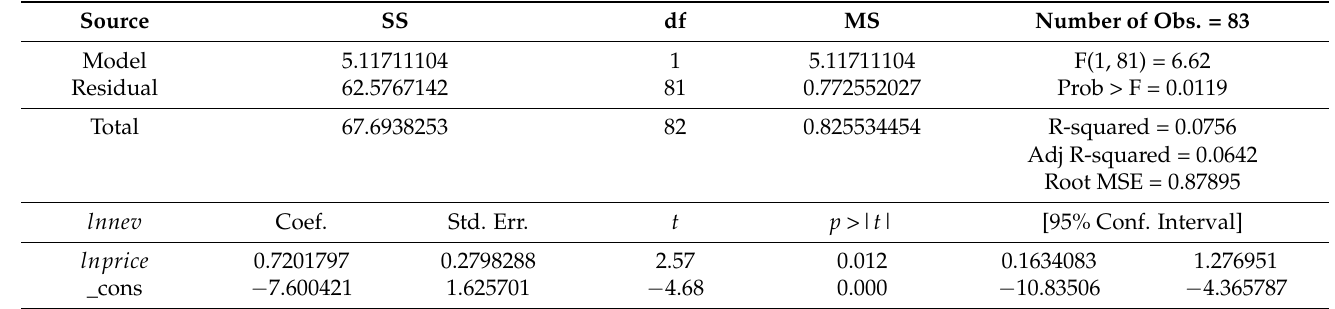
Table 6. New Energy Vehicle Market Share and Crude Oil Price Regression